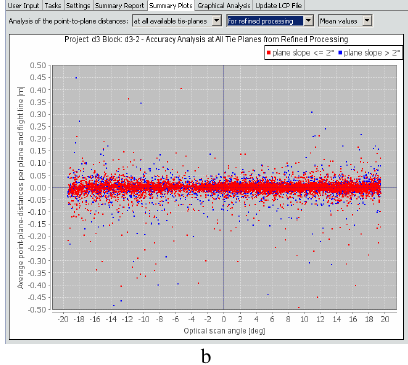
b Figure 4. Point-to-plane distance before (a) and after (b) “First Case” rectification